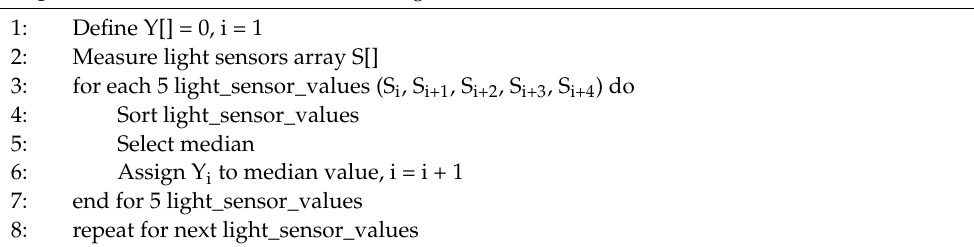
Algorithm 3: Order = 5 Median Filter